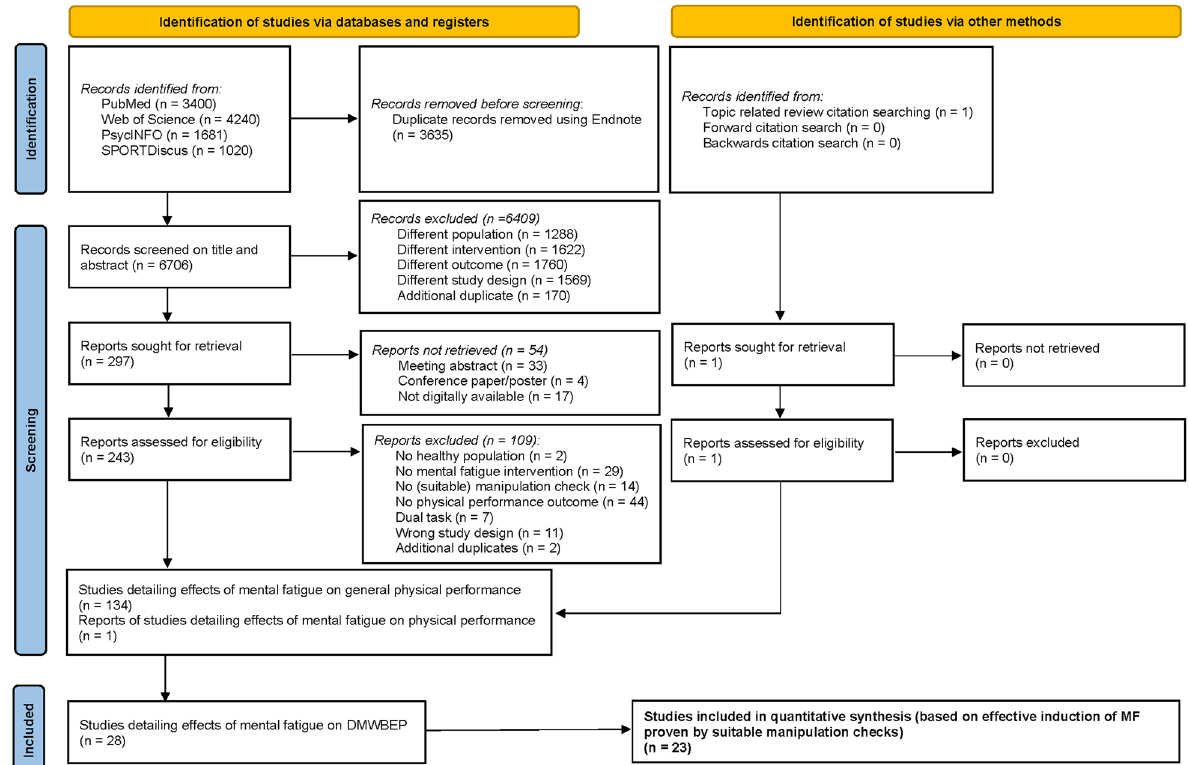
Fig. 1 Prisma chart DMWBEP dynamic maximal whole body endurance